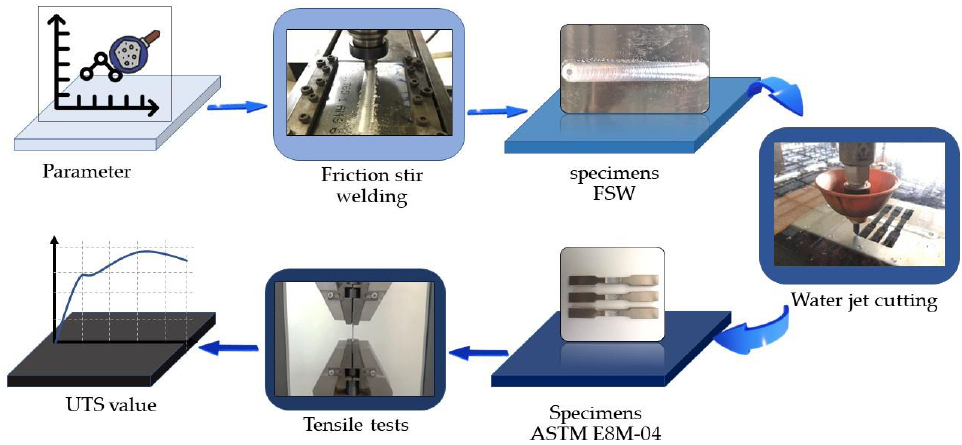
Figure 3. Determination of the ultimate tensile strength (UTS).